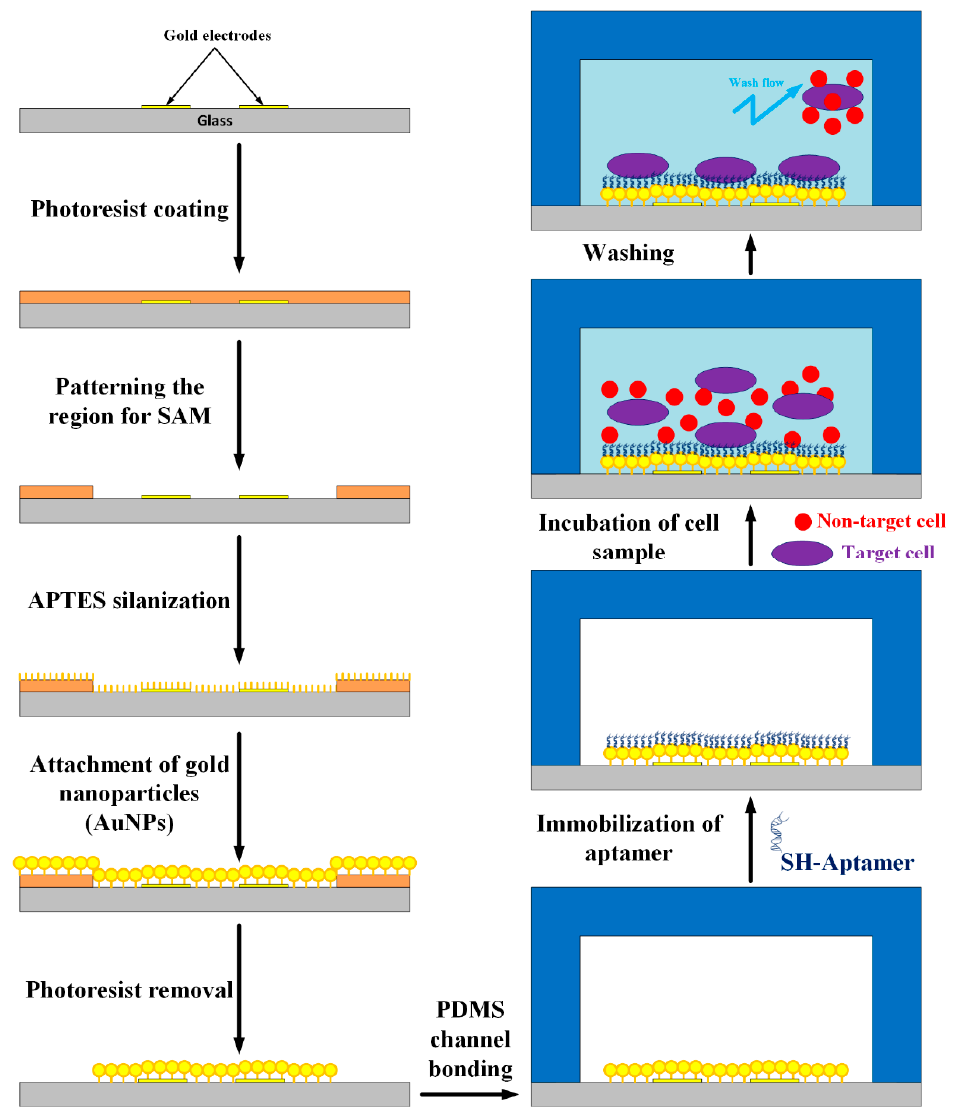
Figure 2. Illustration of aptamers modification procedure onto the SAM of AuNPs in the channel for binding of target cells.